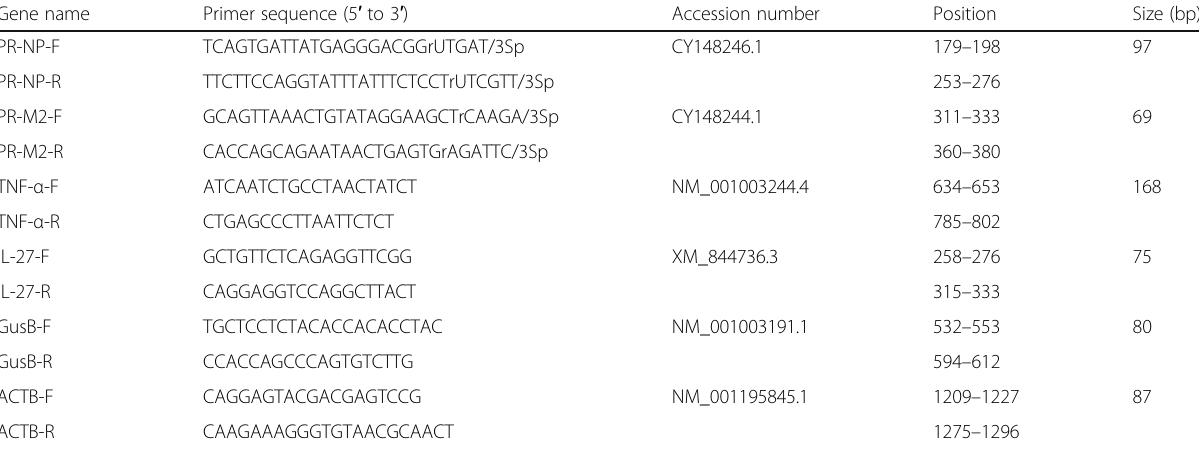
Table 1 The primers specification for amplification of the targeted